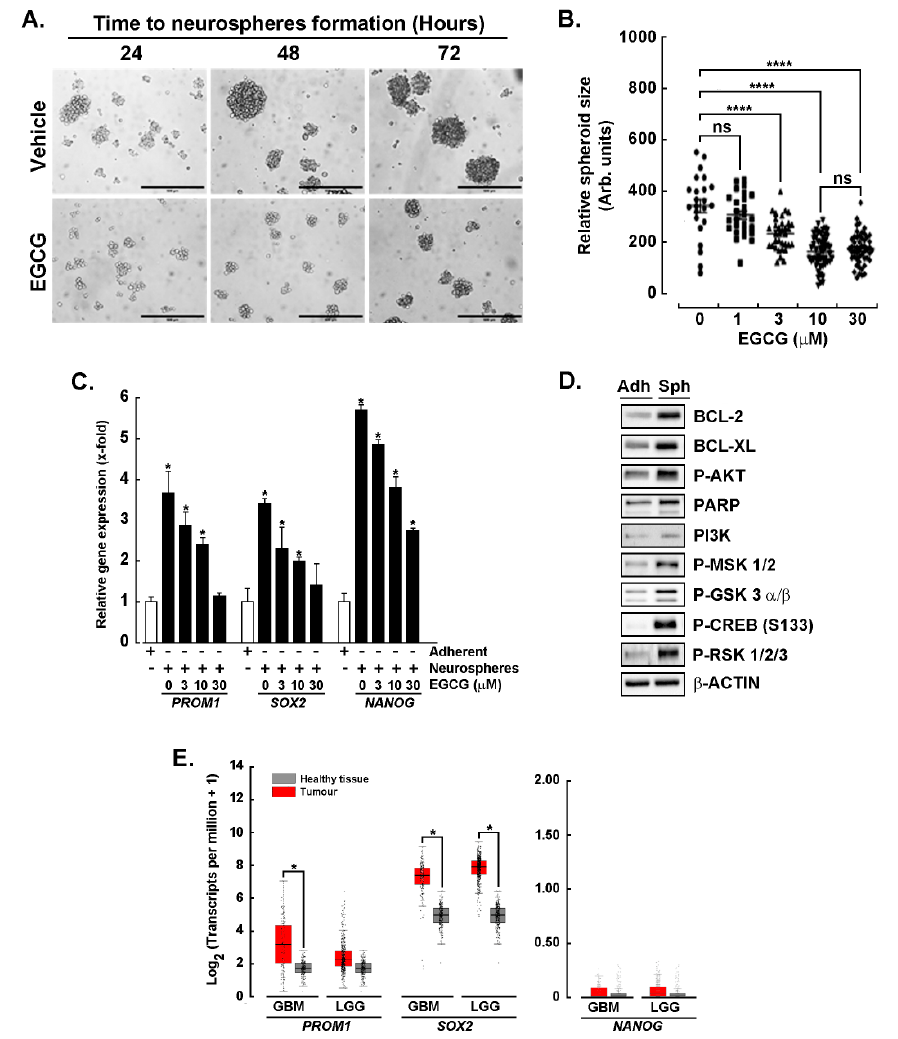
Figure 1. EGCG alters neurospheres size and reverses the acquisition of a cancer-stem cell phenotype. ( A ) U87 glioblastoma monolayers were cultured with the Tumorsphere Medium Xf with SupplementMix for the indicated times in the absence or presence of increasing EGCG concentrations and spheroids. Representative phase contrast pictures were taken, and ( B ) spheroid size was quantified as described in the Methods section (**** = 0.0001 ≥ p; ns = non significant) ( C ) Total RNA was extracted from adherent or neurospheres generated upon 72 h in the presence of increasing EGCG concentrations. RT-qPCR analysis was used to assess the expression of CSC markers PROM1 , SOX2 , and NANOG . Probability values of 0.05 were judged significant and indicated as (*). ( D ) Cell lysates were harvested from adherent, or spheroids obtained at 72 h. Western blot analysis of protein expression was performed as described in the Methods section of the described markers. Representative blots for each marker are shown from three independent experiments. ( E ) In silico analysis of PROM1 , SOX2 , and NANOG transcript levels was performed on clinical samples from GBM, and low-grade glioma (LGG) and compared to healthy tissue as described in the Methods section. Probability values of 0.05 were judged significant and indicated as (*).